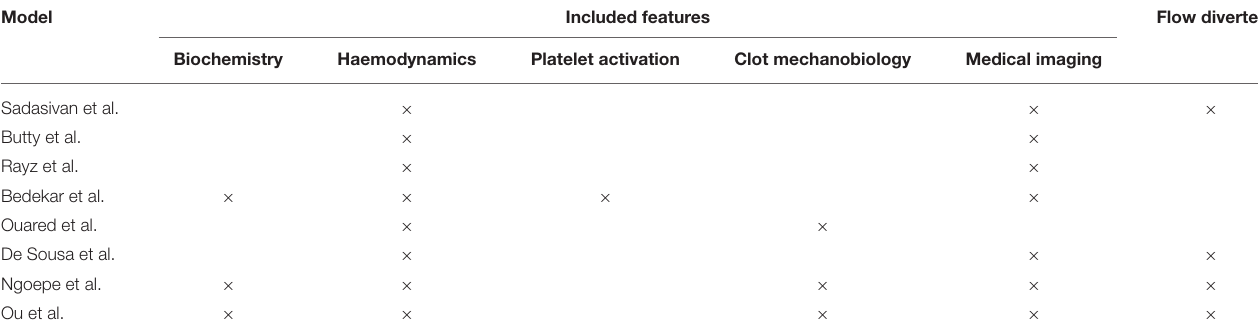
TABLE 4 | Summary of computational cerebral aneurysm thrombosis models, illustrating the aspects of coagulation that each model incorporates.